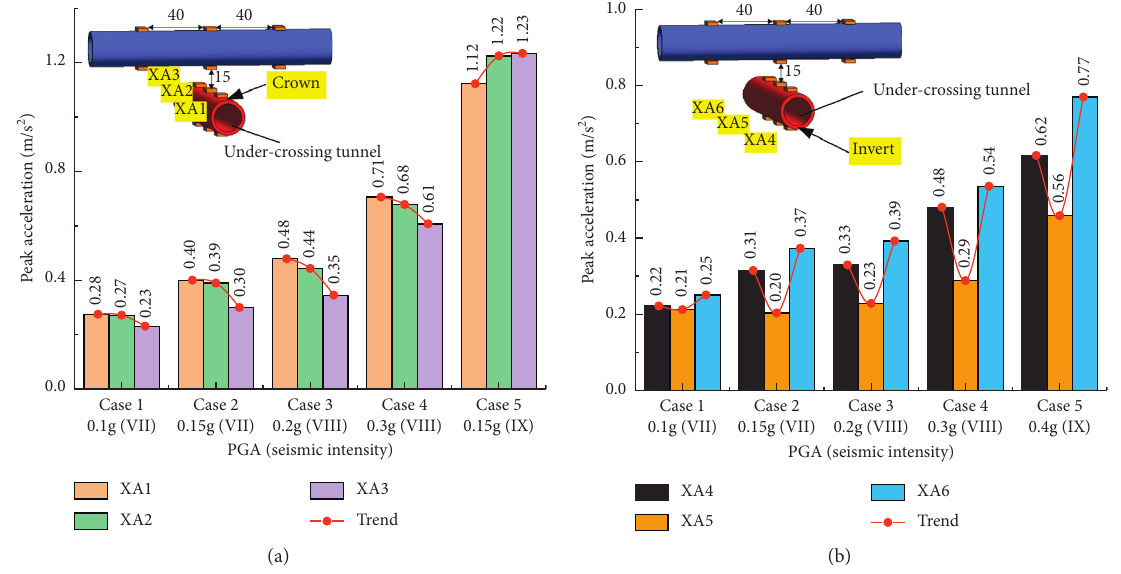
Figure 11: Peak acceleration of the under-crossing tunnel: (a) crown; (d) invert.